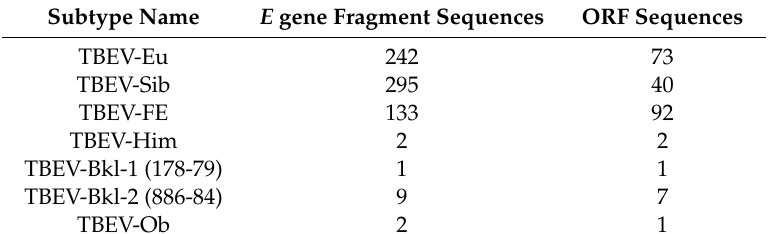
Table 1. Number of known nonidentical sequences for provisional TBEV subtypes.